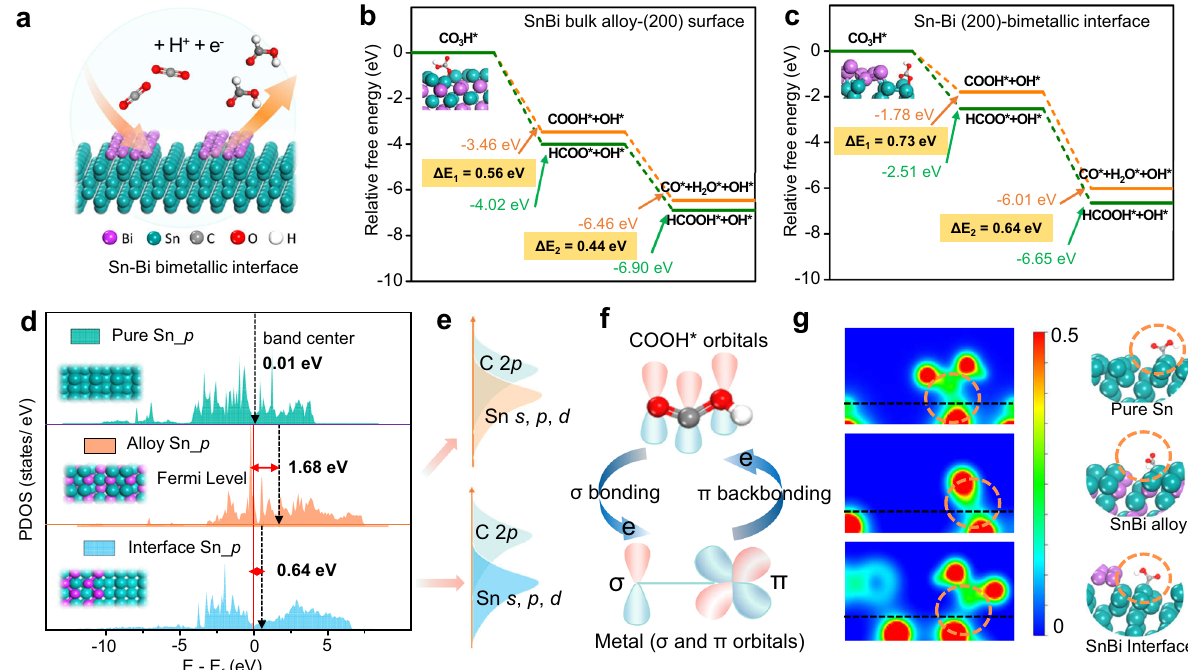
Fig. 1 DFT simulations and proposed catalytic mechanism. a Scheme of CO 2 RR on Sn – Bi bimetallic interface. Gibbs free energy pro fi les of CO and HCOOH production pathways on ( b ) Sn – Bi alloy surface and ( c ) Sn – Bi bimetallic interface. d PDOS of Sn 5 p orbitals of pure Sn, alloy Sn, and interface Sn and weighted band center for all three models without adsorbate (overall range). e Schematic illustration for PDOS overlapping areas of Sn s , p , and d orbitals on Sn – Bi alloy and Sn – Bi bimetallic interface with C 2 p orbitals of COOH*, respectively. f Scheme of σ bonding and π backbonding between COOH and Sn metal. g Calculated volume slices of calculated charge densities and corresponding optimized con fi gurations for the three models with COOH adsorbate. The black dashed lines indicate the positions of the metal